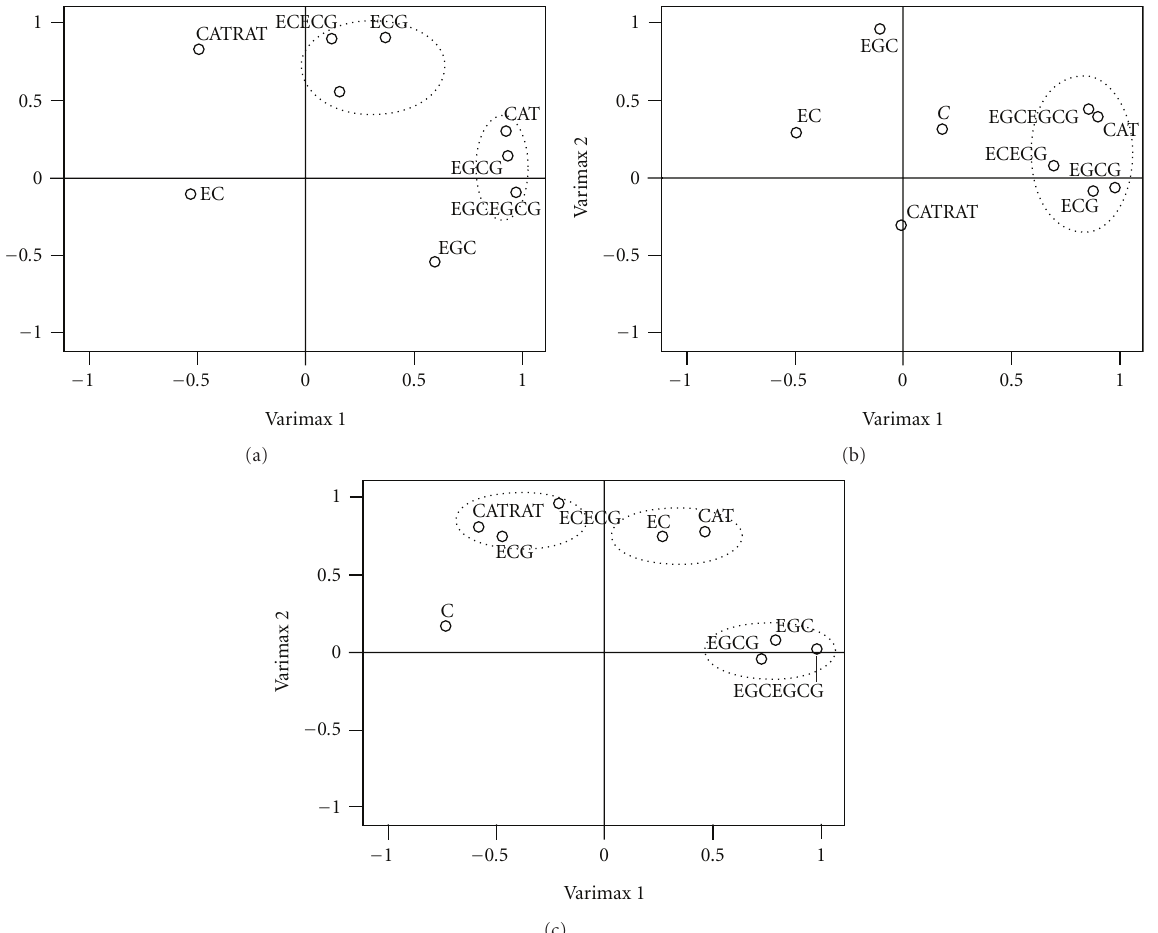
Figure 4: Factor loading pattern of the analyzed variables of the three varieties obtained by PCA followed by Varimax rotation. (a) Assam, (b) Cambod, and (c) China tea (note that in these figures “C” indicates “+C”).